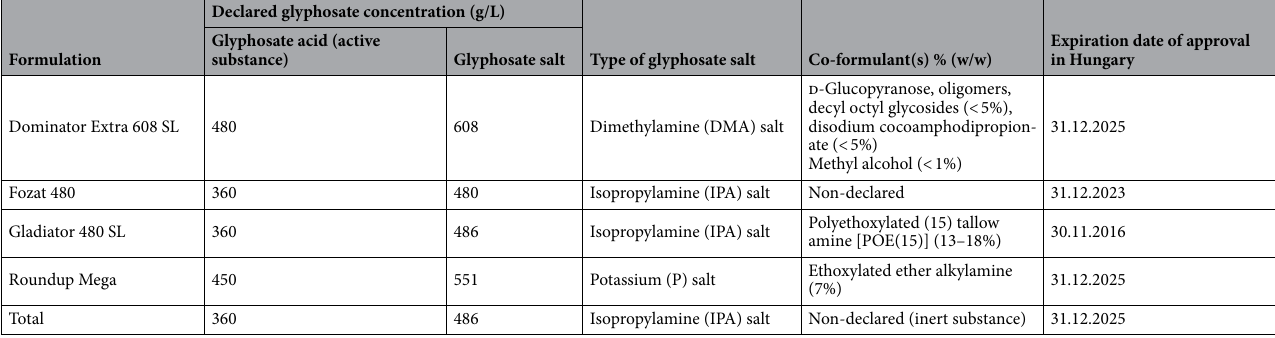
Table 2. Chemical properties of the examined water soluble concentrates of glyphosate-based herbicides (GBHs) examined in this study based on their Material Safety Data Sheets